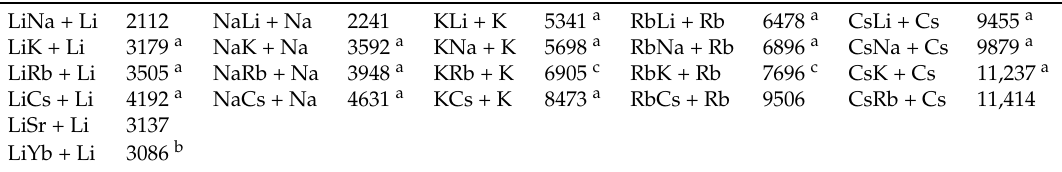
Table 1. Isotropic C iso dispersion coefficients in atomic units for various atom-molecule systems at their 6 equilibrium separation. Values without label a, b, or c have been computed specifically for this paper. LiNa +